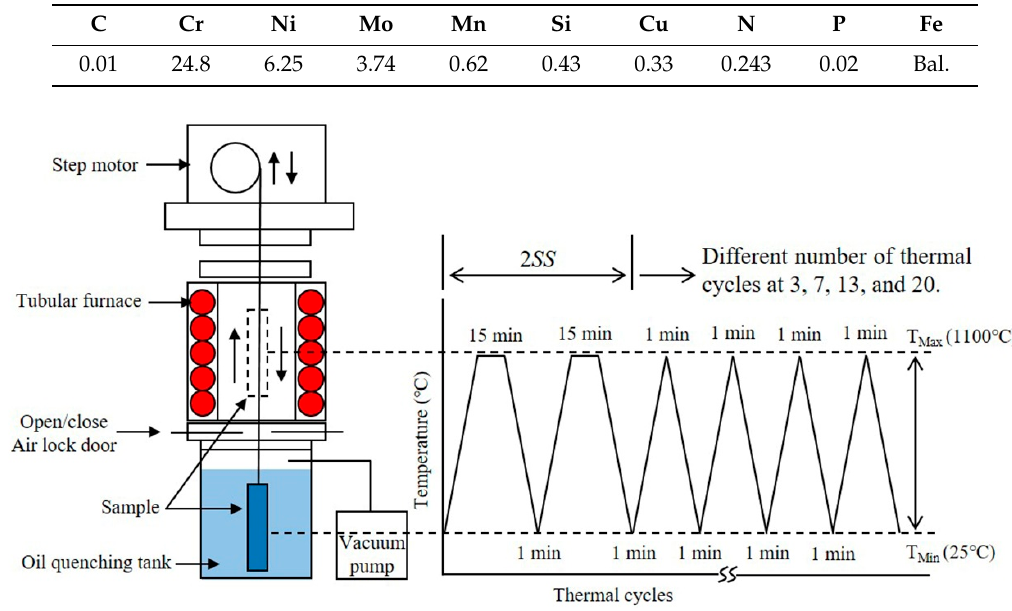
Table 1. Chemical composition of super duplex stainless steel (DSS) SAF 2507 (wt. %) by Glow Discharge Spectrometer.